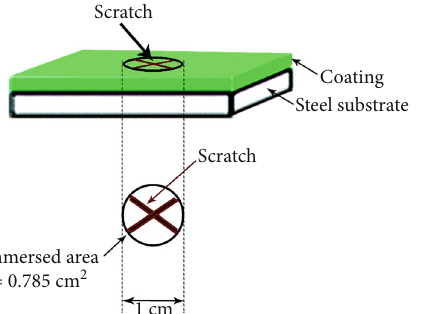
Figure 2: Scheme of the scratch dimensions in the coating to provoke the self-healing